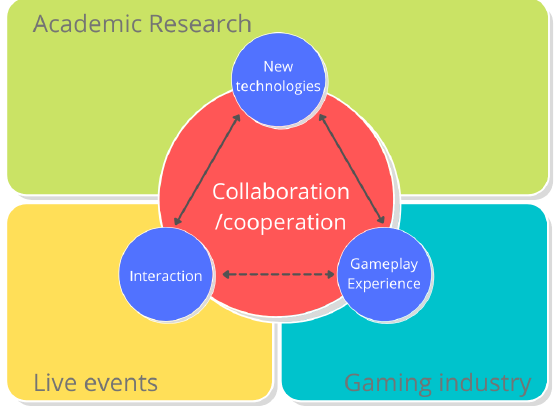
Figure 1. Synthesis of aspects of collaboration and cooperation, where be­ sides academy and traditional game industry,